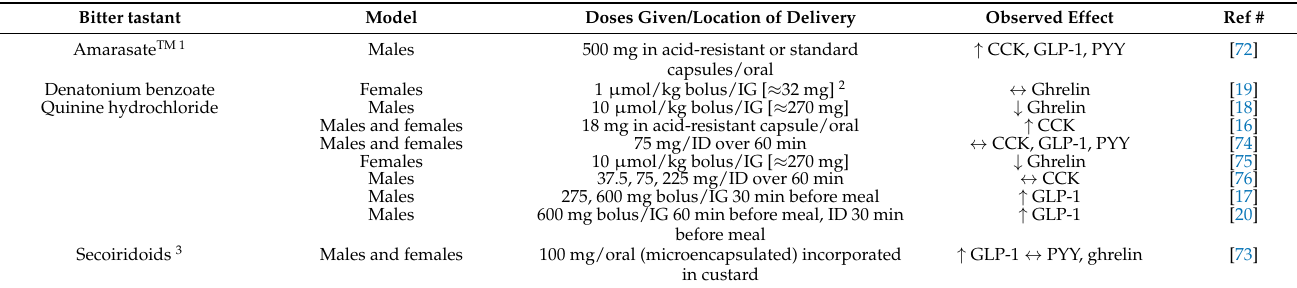
Table 2. Effects of bitter substances on gut hormone secretion in healthy